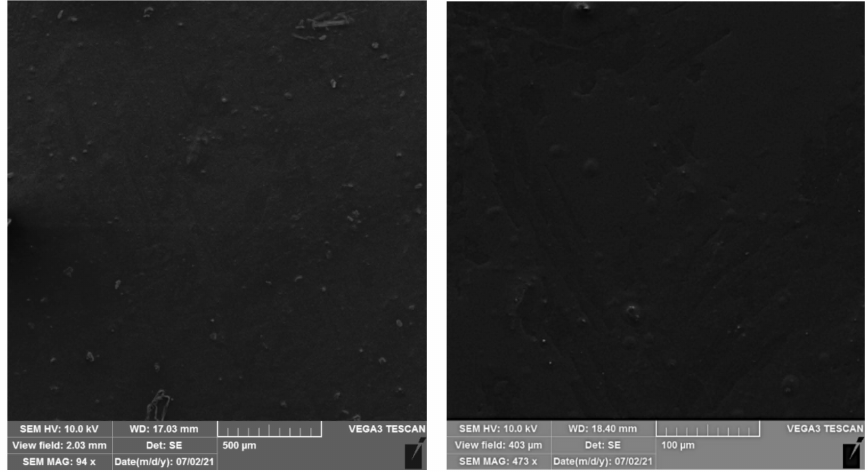
Figure 8. The SEM images of aPE films. K—PE film; aPE—PE film containing a mixture of CO 2 extracts of raspberry seeds, pomegranate seeds, and rosemary in polymer matrix.